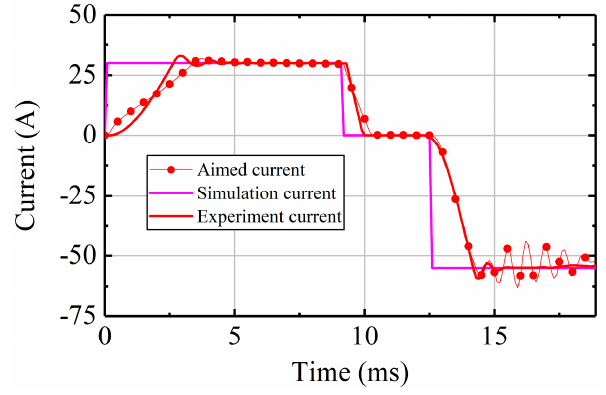
Figure 15. The current verification (stable operation).